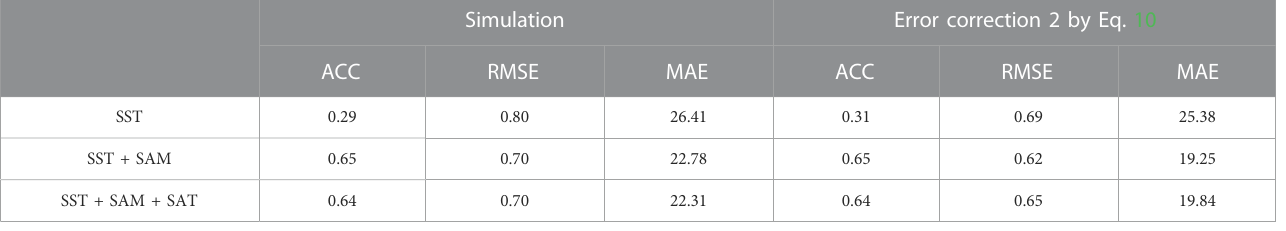
TABLE 4 Evaluations of simulated and corrected Weddell Sea SIC anomaly during 2003 – 2012.